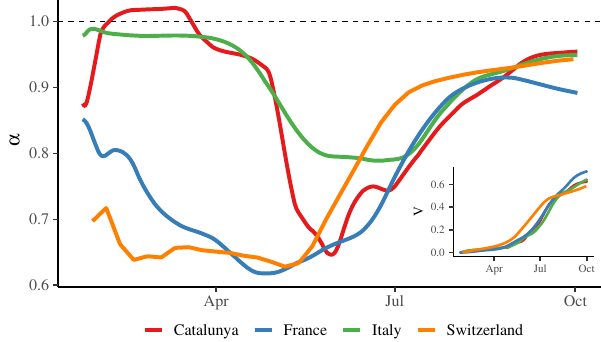
Fig. 1 Mixing parameter from age-strati fi ed data on vaccine uptake. Weekly moving average of the mixing parameter, α , as inferred for different countries/regions starting from the contact matrix among age groups and the SARS-CoV-2 vaccines uptake of each group (whose aggregate, V , is shown in the inset plot) from January to September